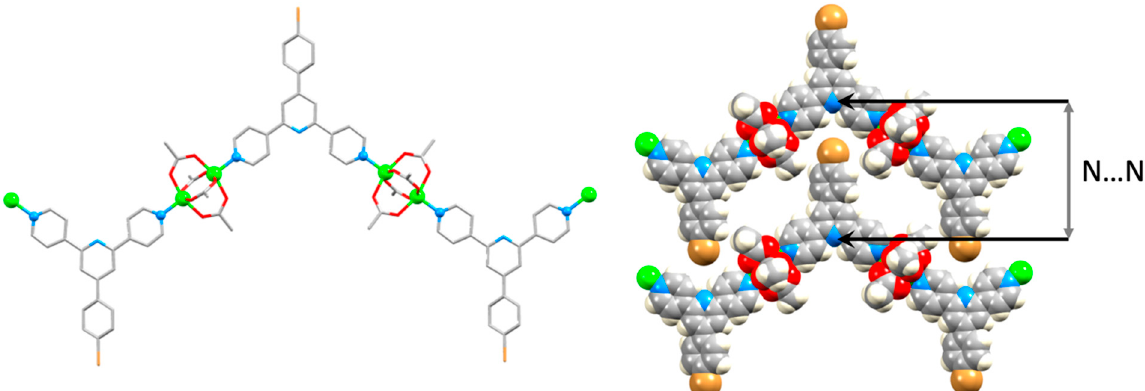
Figure 15. Part of the 1D-zigzag coordination polymer chain in [Zn 2 ( µ -OAc) 4 (4 (cid:48) -(4-BrC 6 H 4 )-4,2 (cid:48) :6 (cid:48) ,4 (cid:48)(cid:48) -tpy)] n (CSD refcode CUXCOO) and a space-filling representation of parts of two adjacent chains showing packing to form 2D-layers. The defined N...N distance gives a measure of the separation between chains in a given layer (see text).